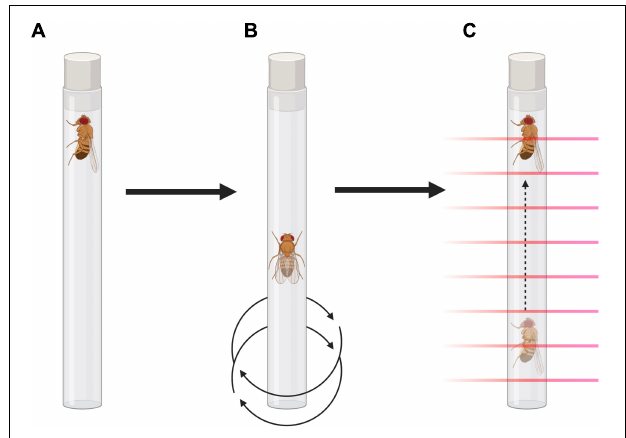
FIGURE 1 | Forced-climbing protocol illustration. (A) Flies are placed vertically in individual tubes for measurement in the MB5-Monitor. (B) A programmable vortex plate agitates the apparatus for 4 s, each minute, in a 6-h protocol. (C) Climbing is assessed by the MB5-Monitor by recording beam-to-beam